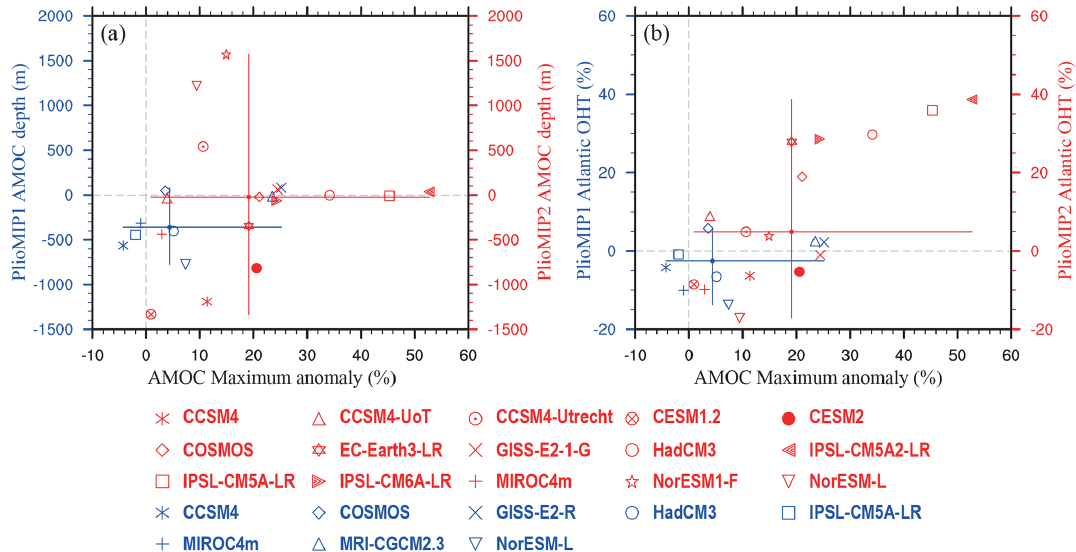
Figure 2. Simulated changes in the AMOC maximum, depth and Atlantic northward OHT. (a) Changes in the AMOC maximum (unit: %) vs. responses in the mean depth of the AMOC cell (unit: m). (b) Changes in the AMOC maximum (unit: %) vs. responses in the mean ocean heat transport in the Atlantic between 30 ◦ S and 80 ◦ N (unit: %). The blue markers show the PlioMIP1 simulations, and the red markers show the PlioMIP2 simulations. The vertical and horizontal lines show the model range, and the intersection of these lines indicates the median value. Note that only the mean values of the AMOC maximum, depth and Atlantic northward OHT for each model are used here to calculate the anomalies, and significance tests are not employed.